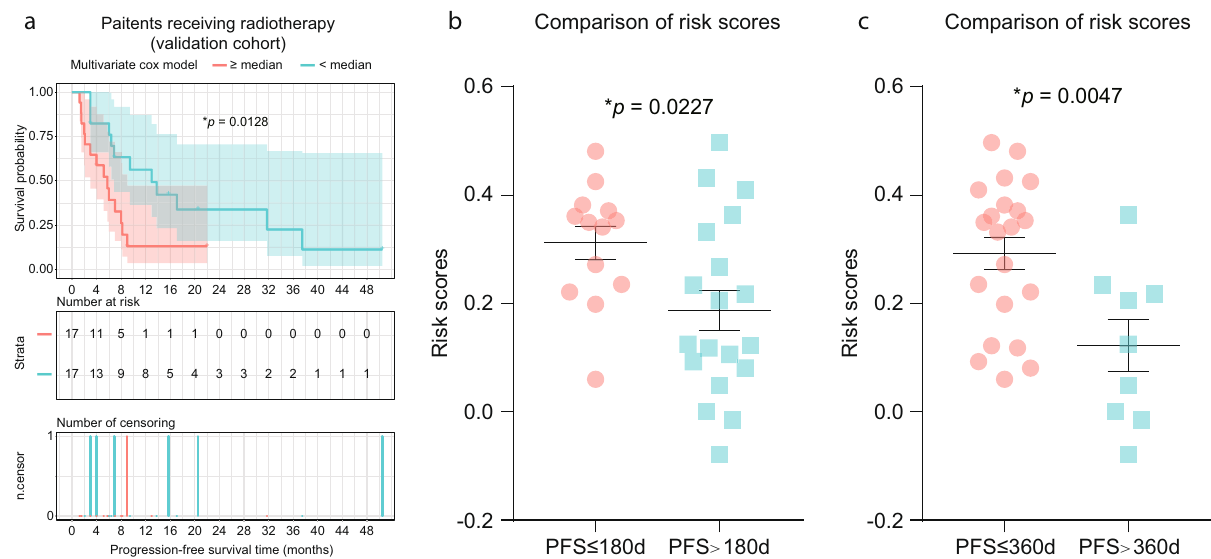
Fig. 4 Con fi rmation of risk scores ’ predictive power in the survival outcome for the validation cohort. a Progression-free survival (PFS) for patients in the validation cohort. The hazard ratio (HR) was estimated by means of a Log-rank test. The 95% CI for HR was shown as a dashed line, in the respective color. Red line, patients with a higher risk score (RSK); blue line, patients with a lower RSK. b , c RSKs between varied survival bene fi ts from radiotherapy. PFS ≤ 180 or 360 days, patients reached endpoint earlier than speci fi ed days; PFS > 180 or 360 days, patients reached endpoint later than speci fi ed days, or ongoing response at speci fi ced days. Horizontal line, mean value; error bars, s.e.m. Statistics based on two-tailed Student ’ s t